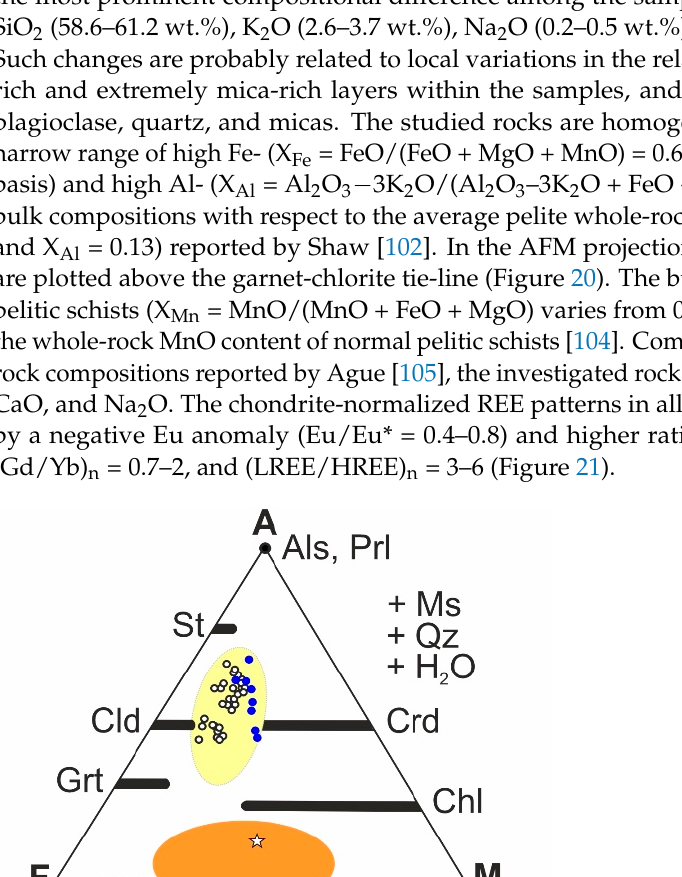
Figure 21. Chondrite-normalized REE patterns [99] ( a ) and primitive mantle-normalized spidergrams [101] ( b ) for the metapelites of the Teya and Angara Complexes.